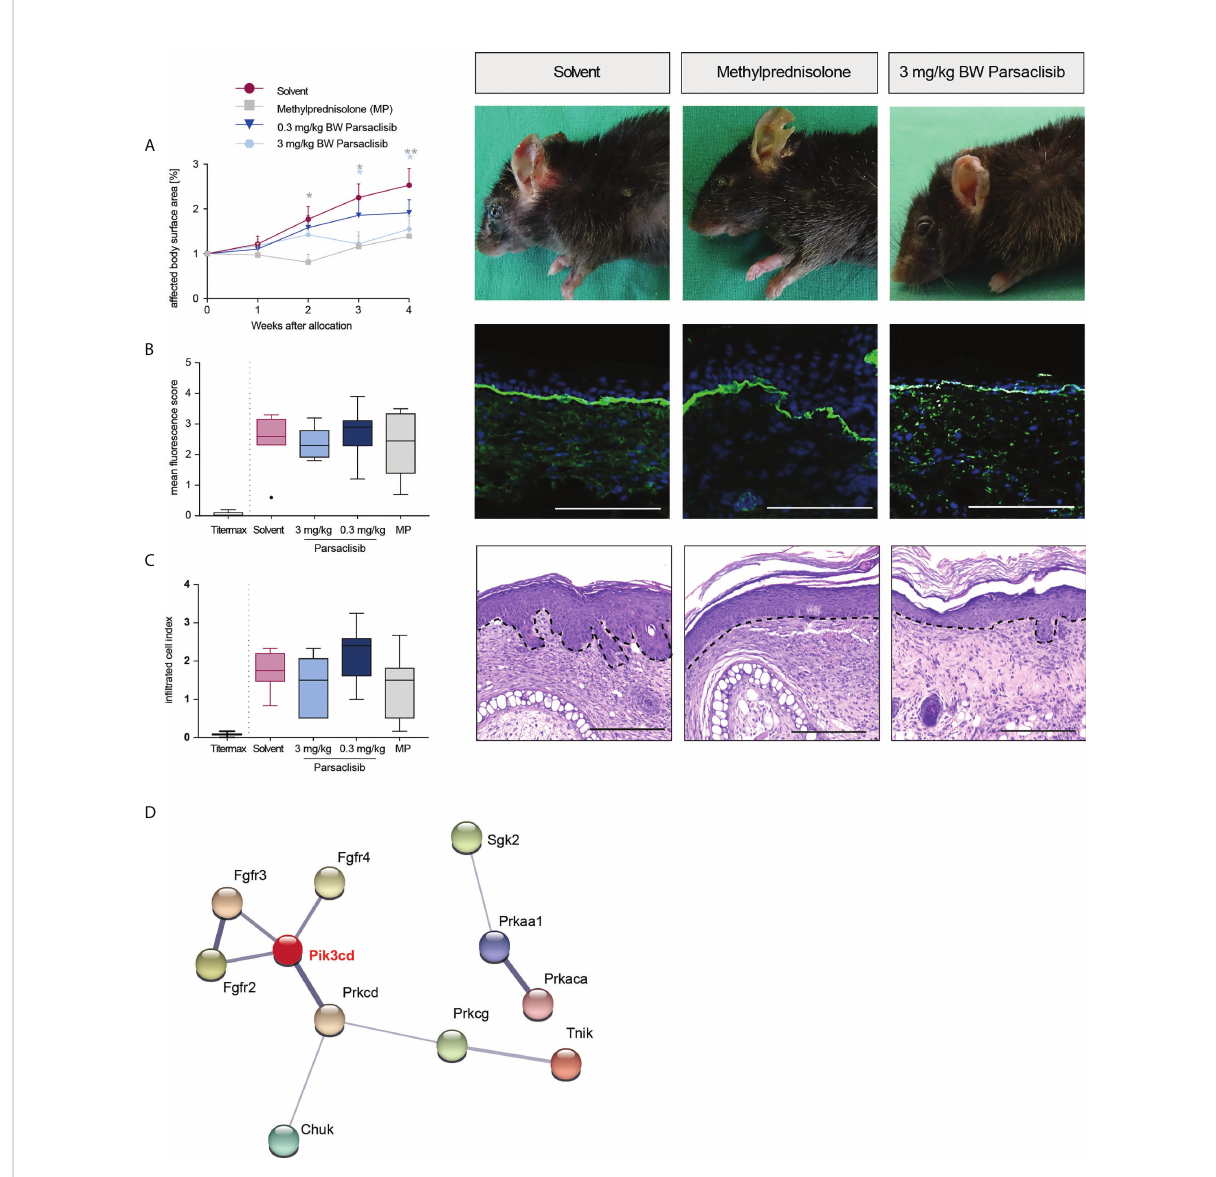
FIGURE 3 Parsaclisib improves the clinical outcome in immunization-induced EBA. B6.s mice were immunized with 120 m g of mCOL7 vWFA2 emulsi fi ed in Titermax ™ . If 2% or more of the body surface area was covered with lesions in individual mice, these animals were treated with different concentrations of parsaclisib or methylprednisolone (MP), n=9/group. (A) Relative magnitude of affected body surface area in relation to the time of allocation over the time and representative clinical images of the mice 4 weeks after allocation. Data are shown as mean ± SD. The representative clinical images for the indicated treatments were obtained at the end of the 4-week treatment period. (B) To visualize IgG binding to the dermal-epidermal junction, ear skin was stained for anti-mouse IgG (green) and nuclei (DAPI, blue). Overall, no difference among the groups was noted. Representative direct IF pictures and mean fl uorescent intensity of IgG binding. (C) Representative H&E-stained ear skin at the end of the experiment. The cumulative histological score index (amount of skin in fi ltration, epidermal thickening and split formation at the DEJ) was analyzed in lesional back skin. (B-C) , data are shown as Tukey ’ s box-and-whisker plots. ANOVA on ranks (Kruskal-Wallis) was applied followed by a Dunn´s multiple comparison test. (D) PamGene kinome analysis of lesional skin treated with solvent vs. 3 mg/ml parsaclisib (n=3/ group) was performed. STRING database analysis of kinases that are modulated by parsaclisib; contrasting kinase activation in lesional skin from solvent- to parsaclisib-treated mice. STING interaction modules are shown at the medium con fi dence level. Thickness of the lines indicates the strength of the predicted interaction. Colors of kinases are randomly selected. Differently activated kinases that did not have any connections to other kinases were excluded from the networks. *p<0.05, **p<0.01, scale bar=100